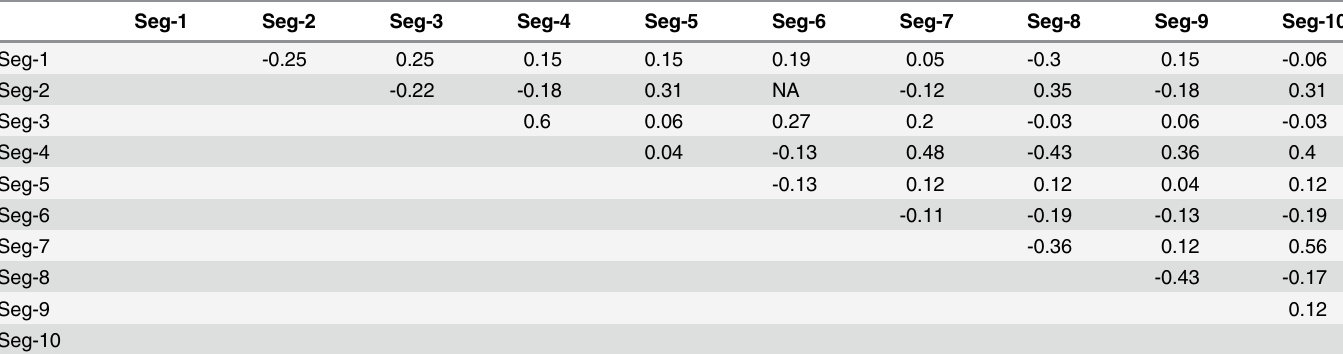
Table 1. Negative and positive pairwise associations among BTV segments during reassortment. None of the p-values were significant after correct- ing for multiple testing using the false discovery rate method. Reassortment was inferred relative to Seg-2, except for associations involving Seg-2, which were inferred relative to Seg-6. Associations between Seg-2 and Seg-6 are therefore not